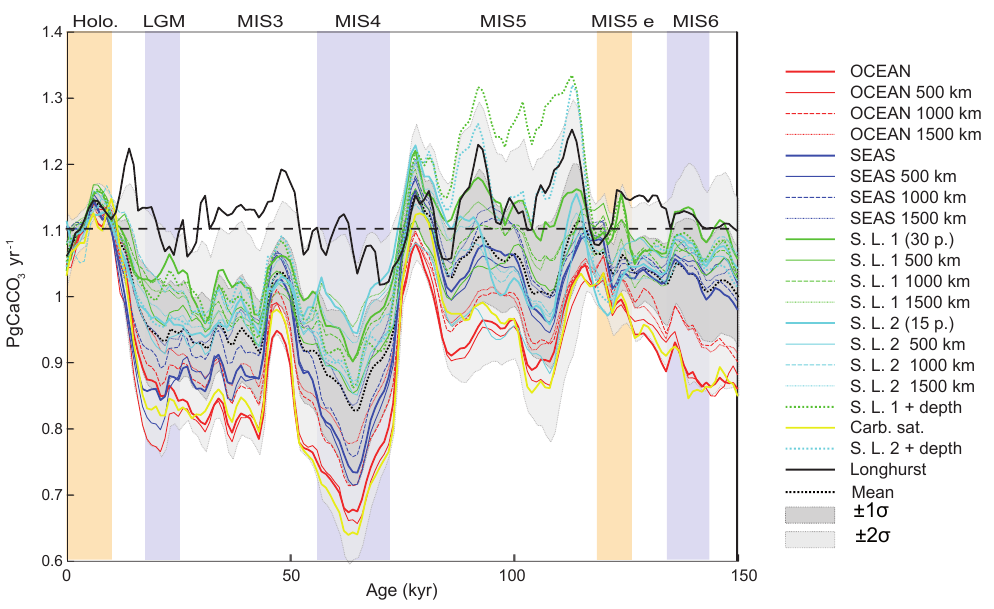
Figure A4. Detail of Fig. 6f corresponding to the final